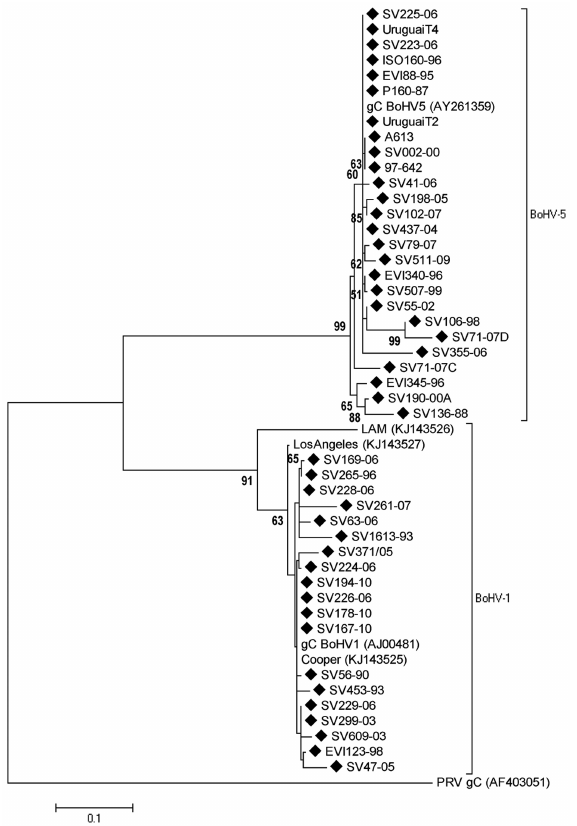
Figure 2. Phylogenetic tree based on the maximum likelihood method for the nucleotide sequence of the 5 9 third of glycoprotein C (gC) gene of 19 bovine herpesvirus 1 (BoHV-1) and 25 BoHV-5 isolates from South America (black diamond; 310 positions). Reference strain sequences are included in the analysis. Only bootstrap values higher than 50% of 2000 replicates are